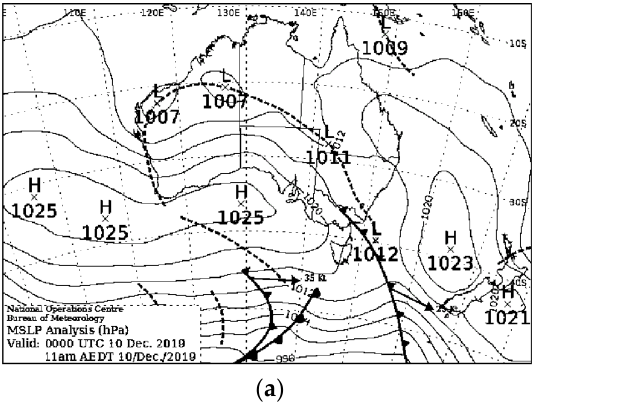
Figure 6. ( a ) Synoptic chart showing isobars (hPa) and frontal systems at 00:00 UTC on 10 December 2019; and ( b ) Skew-T-log-p diagram for the soundings taken in the Sydney region at the same time. ( http://www.bom.gov.au/australia/charts/archive/index.shtml (accessed on15 January 2020)).